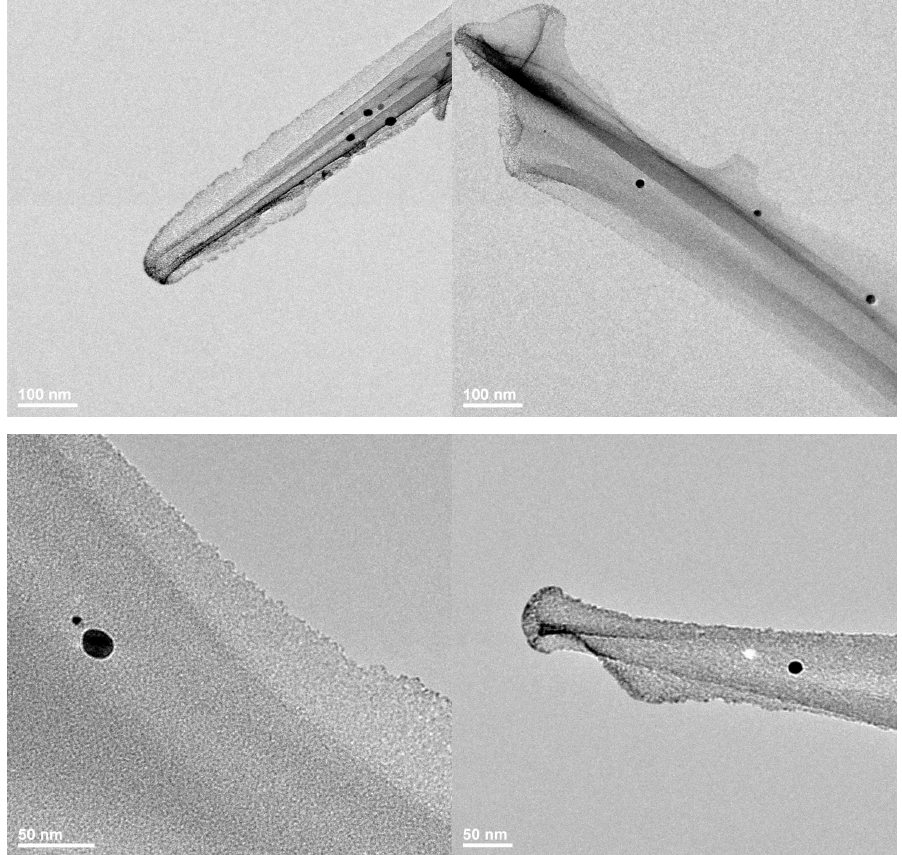
Figure 6. TEM images recorded for PET_2.5_NanoAg.